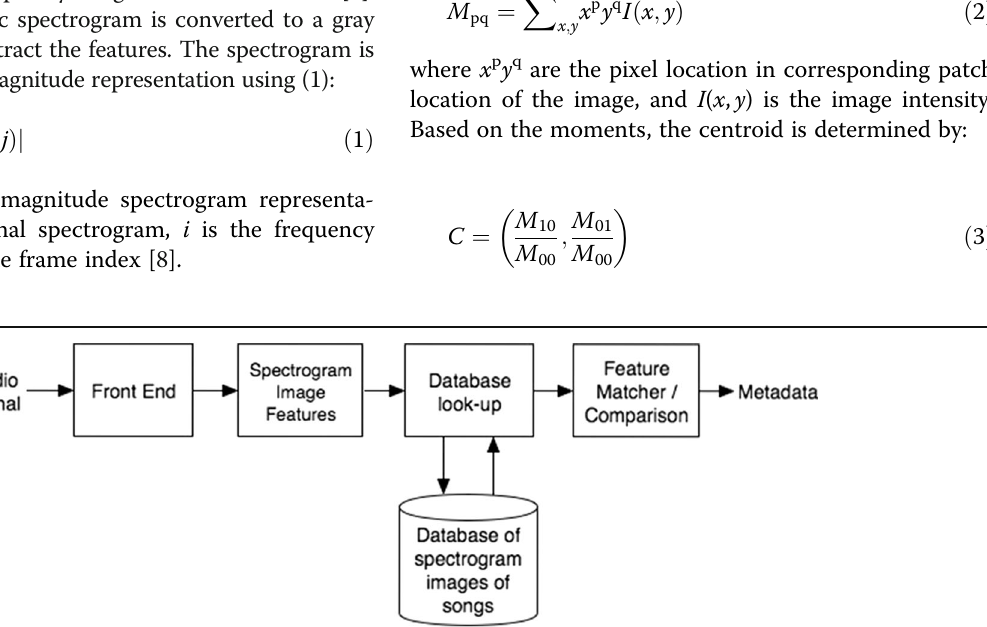
Fig. 2 Proposed system. The figure shows the proposed system where the raw audio would be captured (by loading the audio signal or by microphone). The audio signal is then processed by converting the audio signal into a spectrogram image. The spectrogram image of the sample is compared to the database of spectrogram images of the songs in the database. This is done using an image processing techniques to match the features of the spectrogram image. After the resulting audio fingerprint comparison is done, the corresponding song information for the highest match is